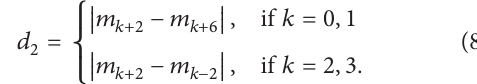
Figure 1: The center pixel 𝑚 𝑐 and its 8 neighborhood